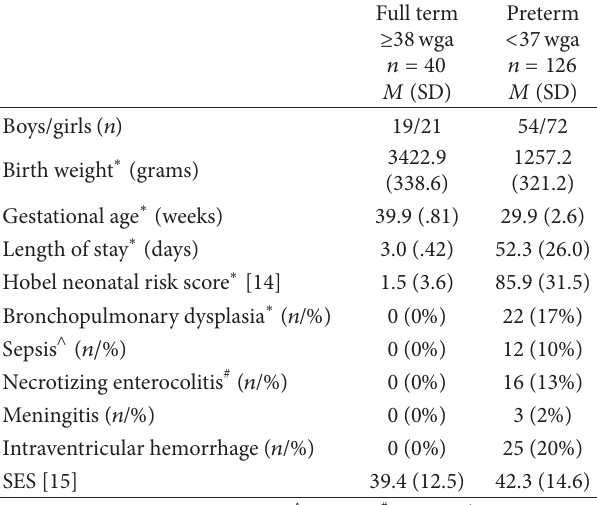
T 2: Neonatal characteristics for study sample by